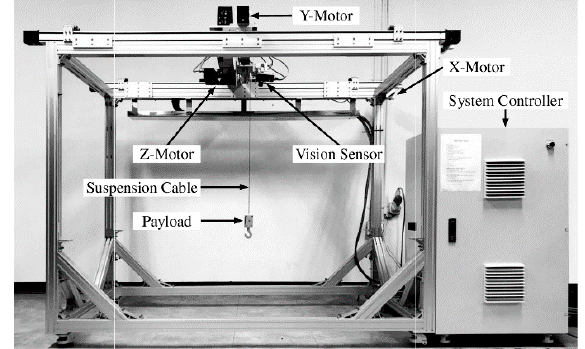
Figure 13. Mini-bridge crane.